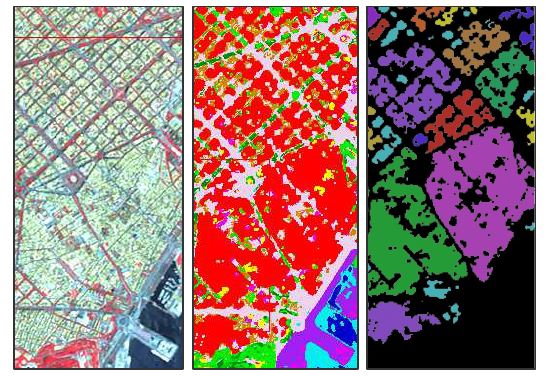
Figure 2: The segmentation result of urban area to following regions size and contents.